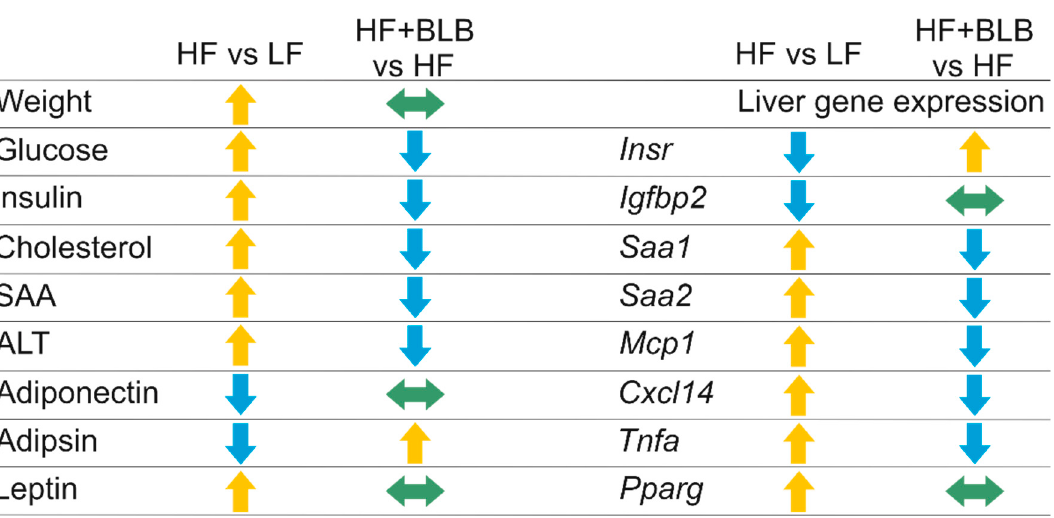
Figure 8. A summary of the effects of bilberry. In the column HF vs. LF, arrows that point upwards and downwards indicate higher or lower levels in the HF group than in the LF group, respectively (i.e., increase or decrease by the HF diet). In the column HF+BLB vs. HF, arrows that point upwards and downwards indicate higher and lower levels in the HF+BLB group than in the HF group, respectively (i.e., the prevention of the HF-diet effect by the bilberry supplementation). Arrows pointing sideways indicate no change in the parameter or gene expression. LF = low-fat diet, HF = high-fat diet, HF+BLB = bilberry-supplemented high-fat diet, SAA = serum amyloid A, ALT = alanine aminotransferase, Insr = insulin receptor, Igfbp2 = insulin-like growth factor binding protein 2, Saa1 = serum amyloid A1, Saa2 = serum amyloid A2, Mcp1 = monocyte chemoattractant protein 1, Cxcl14 = chemokine (C-X-C motif) ligand 14, Tnfa = tumor necrosis factor α , Pparg = peroxisome proliferator-activated receptor γ coactivator 1 α .